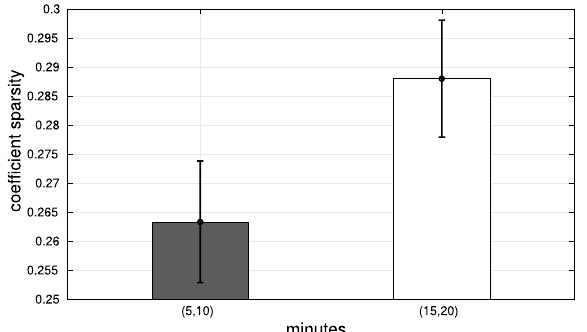
Figure 12. Mean and standard error of coefficient sparsity values for animal R01 behavior in the 2nd and 4th intervals of phase 1 of day 1. The coefficient sparsity values relative to the animal behavior range in [0.25, 0.30]. While the animal learns to navigate in the U maze, coefficient sparsity increases significantly ( F [ 1, 78 ] = 4.197 , p < 0.05 ), revealing an increased stereotypy of behavior.